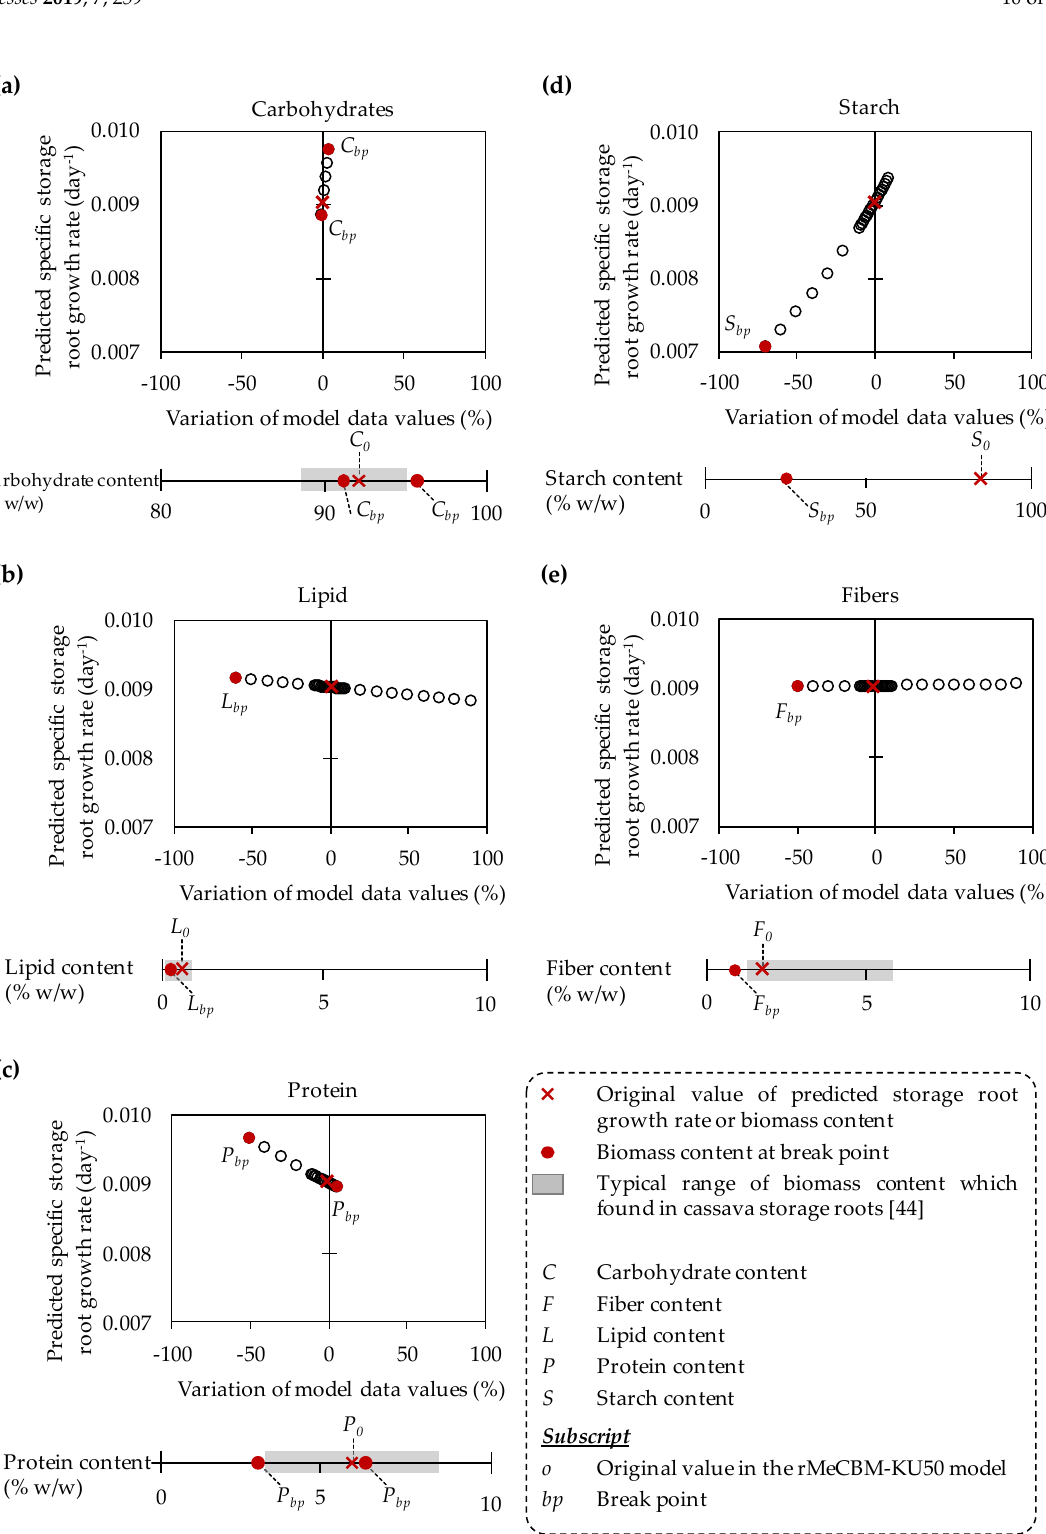
Figure 4. The predicted storage root growth rate of the rMeCBM-KU50 model with the varied biomass function related data: ( a ) Carbohydrates, ( b ) lipids, ( c ) proteins, ( d ) starch, and ( e ) fibers. The biomass content range used, highlighted in gray, was based on values reported for storage roots of several cultivars [44]. A red circle denotes the breakpoint, where the flux direction or partitioning, obtained by varying the biomass contents, differed from the original model. A red cross denotes the original simulation of the rMeCBM-KU50 model.